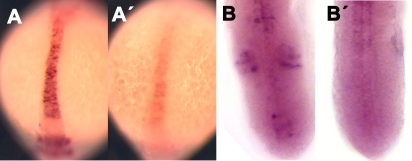
DAPT Treatment Blocks Notch Signalling RapidlyDAPT causes loss of her4 expression (A) in the neural tube and (B) in the anterior PSM (where her4 is normally expressed in a faint but detectable stripe). Wild-type embryos were treated with 100 μm DAPT or with DMSO (control) medium for 1 h and stained by ISH for her4. In each panel, the DMSO control is shown on the left, the DAPT-treated embryo on the right. Treatment was begun at the 13-somite stage for (A) and at the 15-somite stage for (B). For each case, at least 14 embryos were examined, and typical specimens were selected for this illustration.